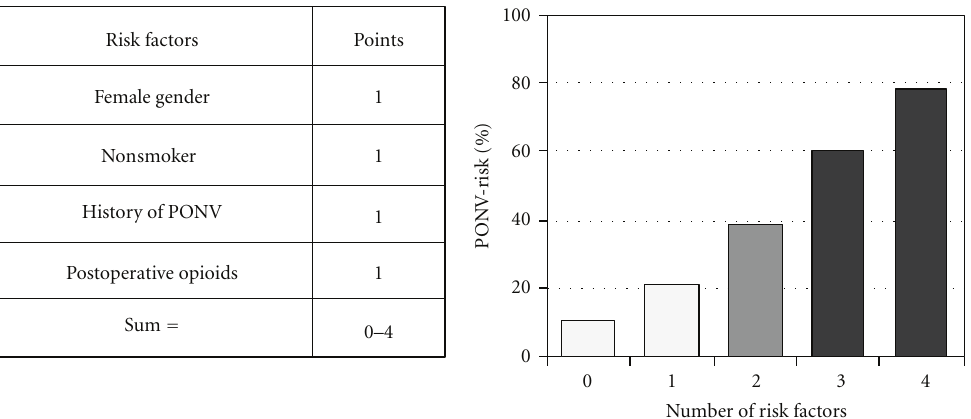
Figure 2: Simplified risk score for PONV in adults. (Reproduced from the original article by Gan et al. [52]).